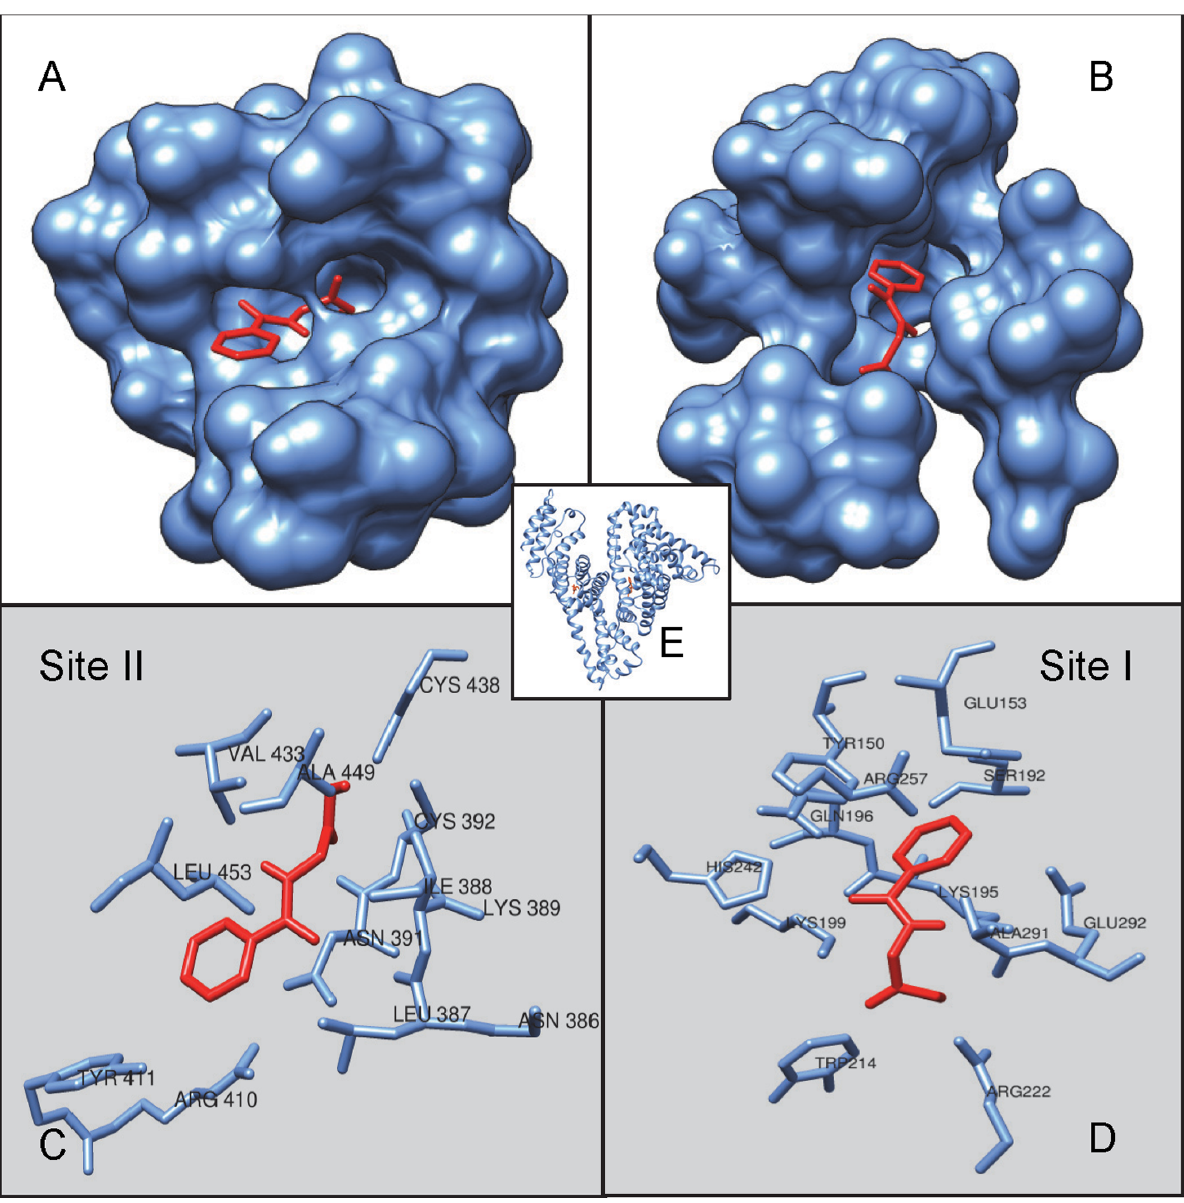
Figure 7. Molecular docking of HA and HSA. (A) Molecular surface representation of docked HA in a site II (A) and site I (B) of HSA. Cartoon representation of residue of HSA site II (C) and site I (D) interacting with HA.